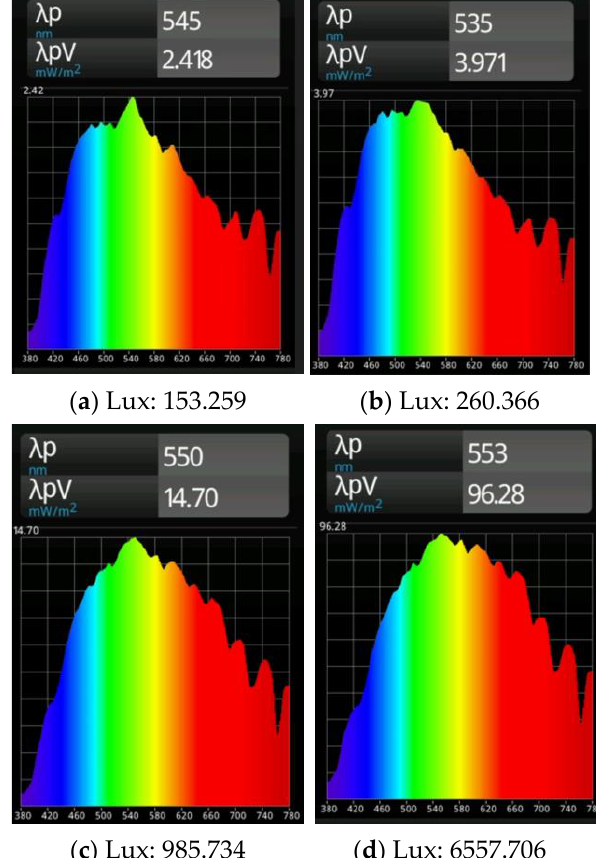
Figure 9. Comparison of illumination intensity (values below the figures in lux) and spectral distri- bution for the spectrum test points S1 located near the center of room 1 (left) and room 2 (right). Results at the top refer to foggy weather conditions ( a , b ); results in the bottom line to a partly cloudy sky ( c , d ).